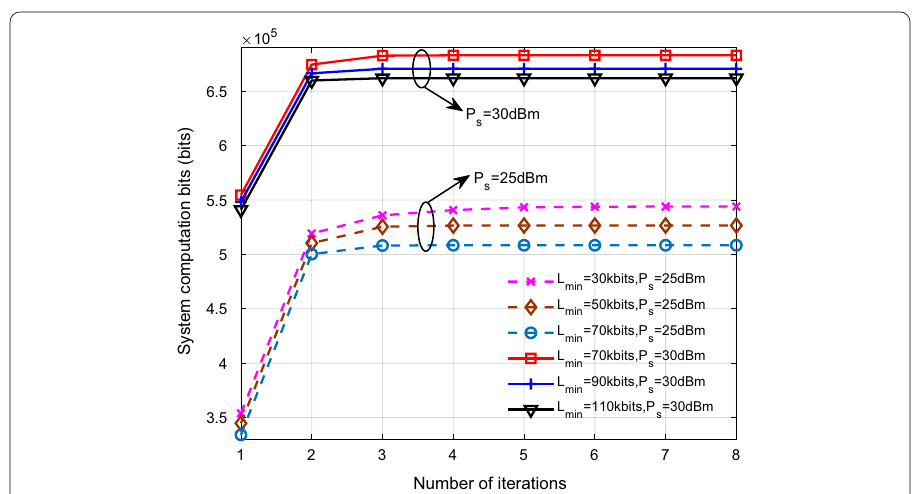
Fig. 2 The convergence analysis of Algorithm